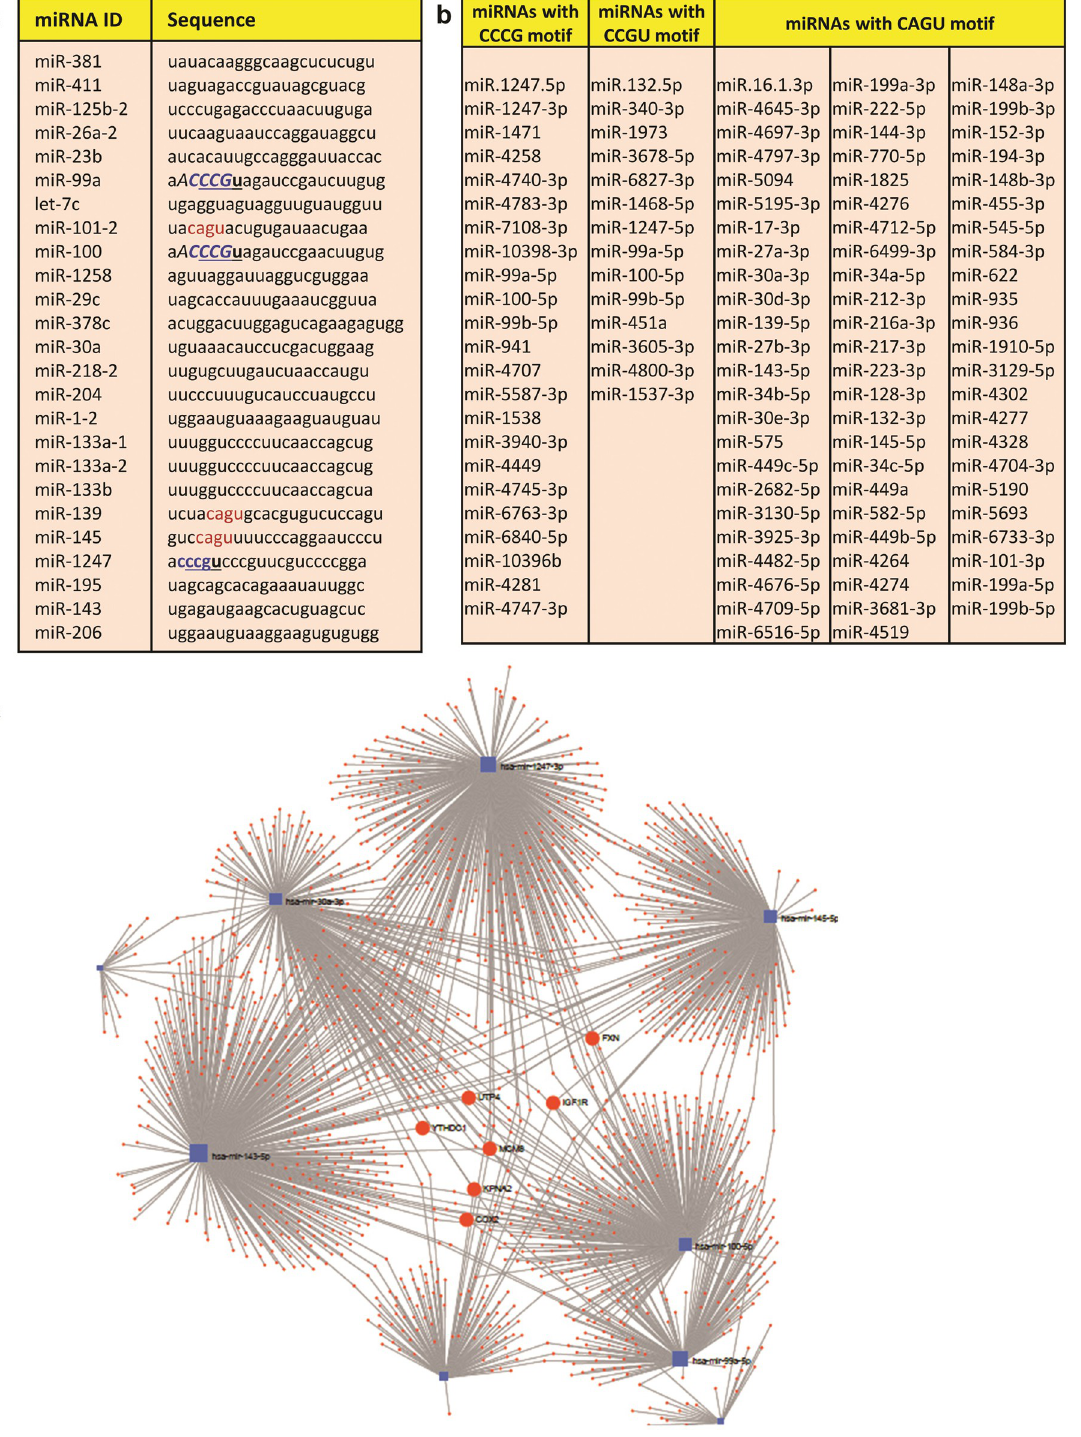
PLOS ONE | https://doi.org/10.1371/journal.pone.0267291 April 27,